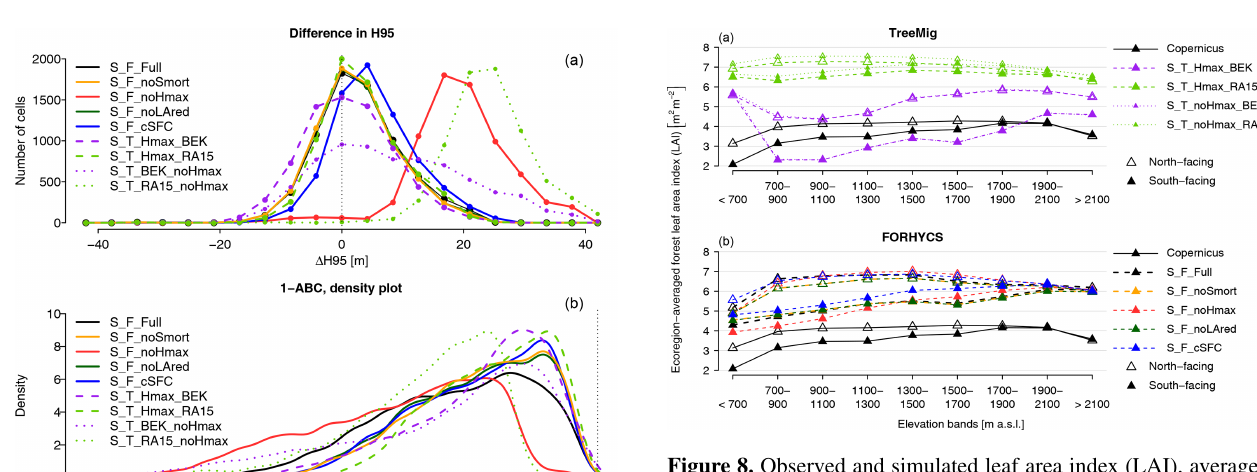
Figure 8. Observed and simulated leaf area index (LAI), averaged over elevation bands and aspect classes. The observed values show the average of cell-level maximum LAI of the period 2014–2016. The simulated values correspond to the averages of the largest an- nual maximum LAI values in the last three years of the succession runs (2013–2015). Graph (a) shows LAI simulated with TreeMig, using two different parameterizations for soil moisture storage ca- pacity. The purple symbols show results of TreeMig runs parame- terized with the soil suitability map (BfR, 1980), whereas the green symbols correspond to TreeMig runs parameterized with the dataset of Remund and Augustin (2015). Graph (b) shows the results of the various FORHYCS succession runs, with the configurations listed in Table